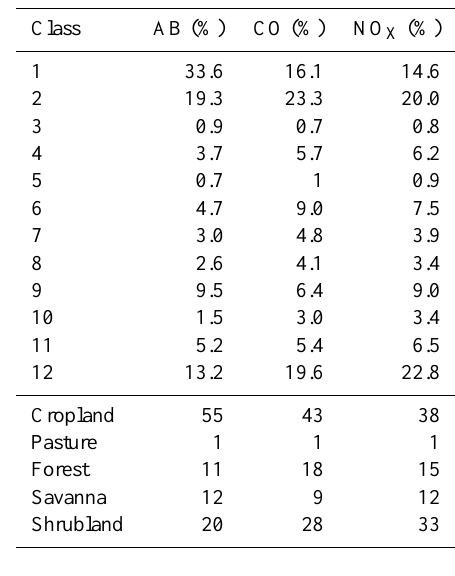
Table 7. Partitioning of area burned (AB) and CO and NO X emis- sions for each CLC category, on average over the 2003–2010 time period, and in the Euro-Mediterranean area. The sum over large veg- etation types is provided in the last lines of the table. About 1% of emissions are in other